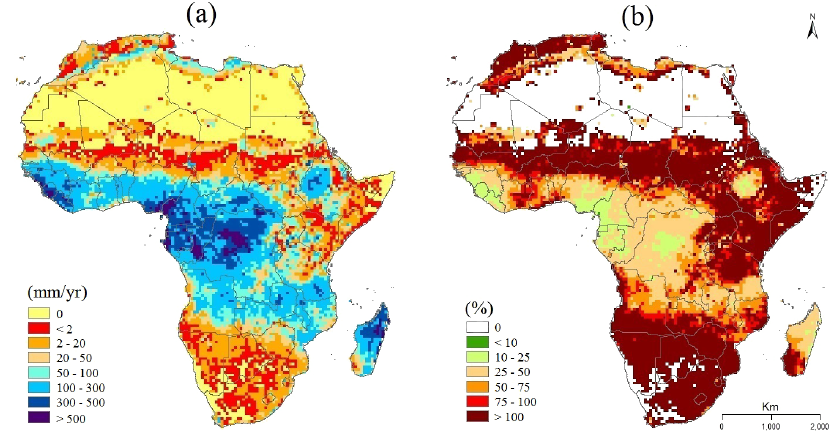
Figure 8. Average annual recharge (mmyear − 1 ) and (b) its coefficient of variation (%), both over the period 1960–2000 (data from Van Beek et al., 2011). Table 6. Aggregated groundwater available (km 3 year − 1 ) for the three environmental scenarios. Scenario 1 Scenario 2 Scenario 3 Min. ∗ Average Max. ∗ Min. Average Max. Min. Average Max. 442.2 692.1 990.1 751.1 1168.3 1664.9 1006.1 1644.5